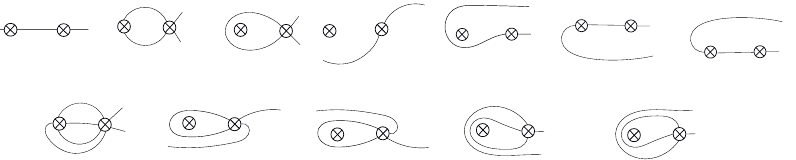
Figure 21. Standard arcs (top row) and examples for twisted arcs (bottom row) that are straight in S (cid:48) i + 1